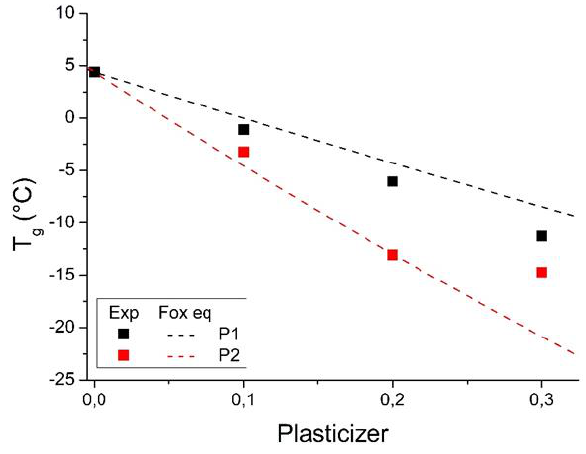
Figure 6. Experimental values of the change in T g for PHB blends as a function of the concentration of the plasticizers. The dotted lines show the T g theoretical model based on the Fox equation.